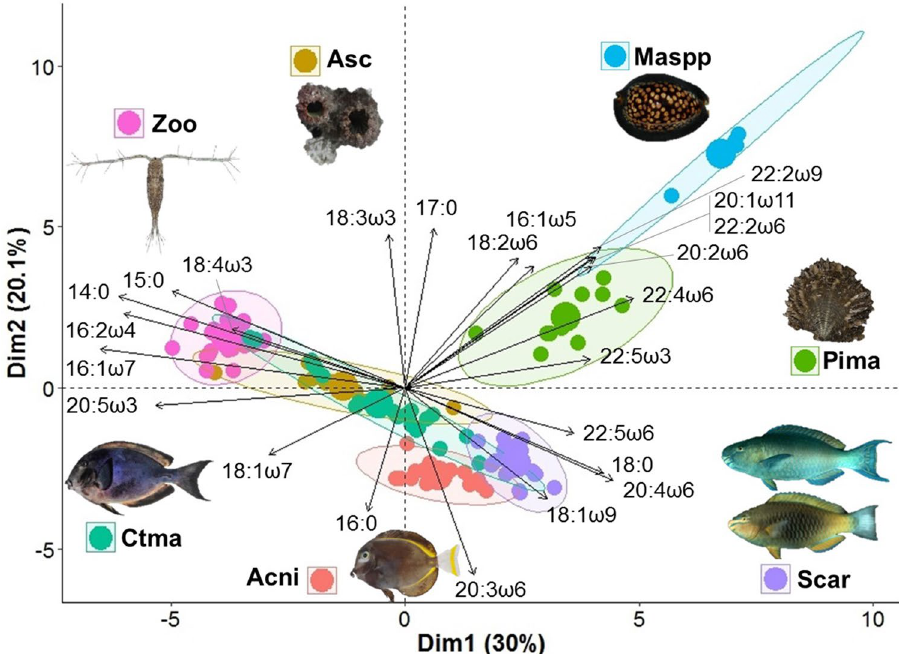
Figure 1. PCA of fatty acid (FA) compositions of the invertebrates (excluding sponges) and fishes. Codes of species: Asc: ascidians, Pima: Pinctada margaritifera , Maspp: Mauritia spp., Zoo: zooplankton, Acni: